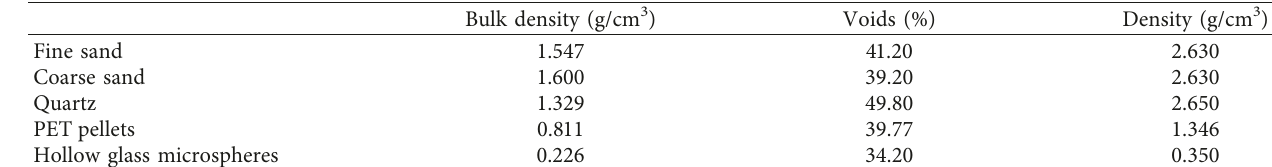
Figure 1: (a) Traditional aggregates (ground quartz and fine and coarse natural sand) and (b) lightweight nontraditional aggregates (PET pellets and hollow glass microspheres). Table 2: Traditional and nontraditional aggregates properties.